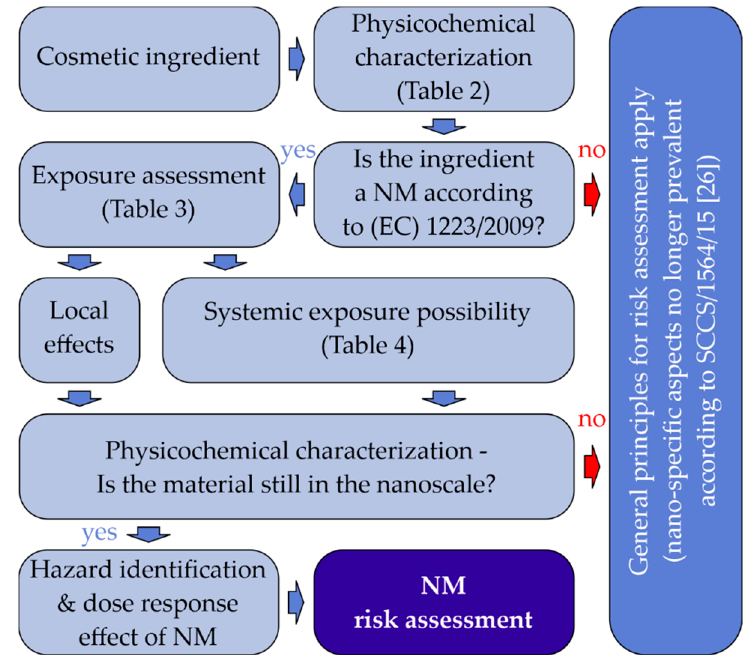
Figure 1. Schematic outline for the safety assessment of nanomaterials in cosmetics [17].